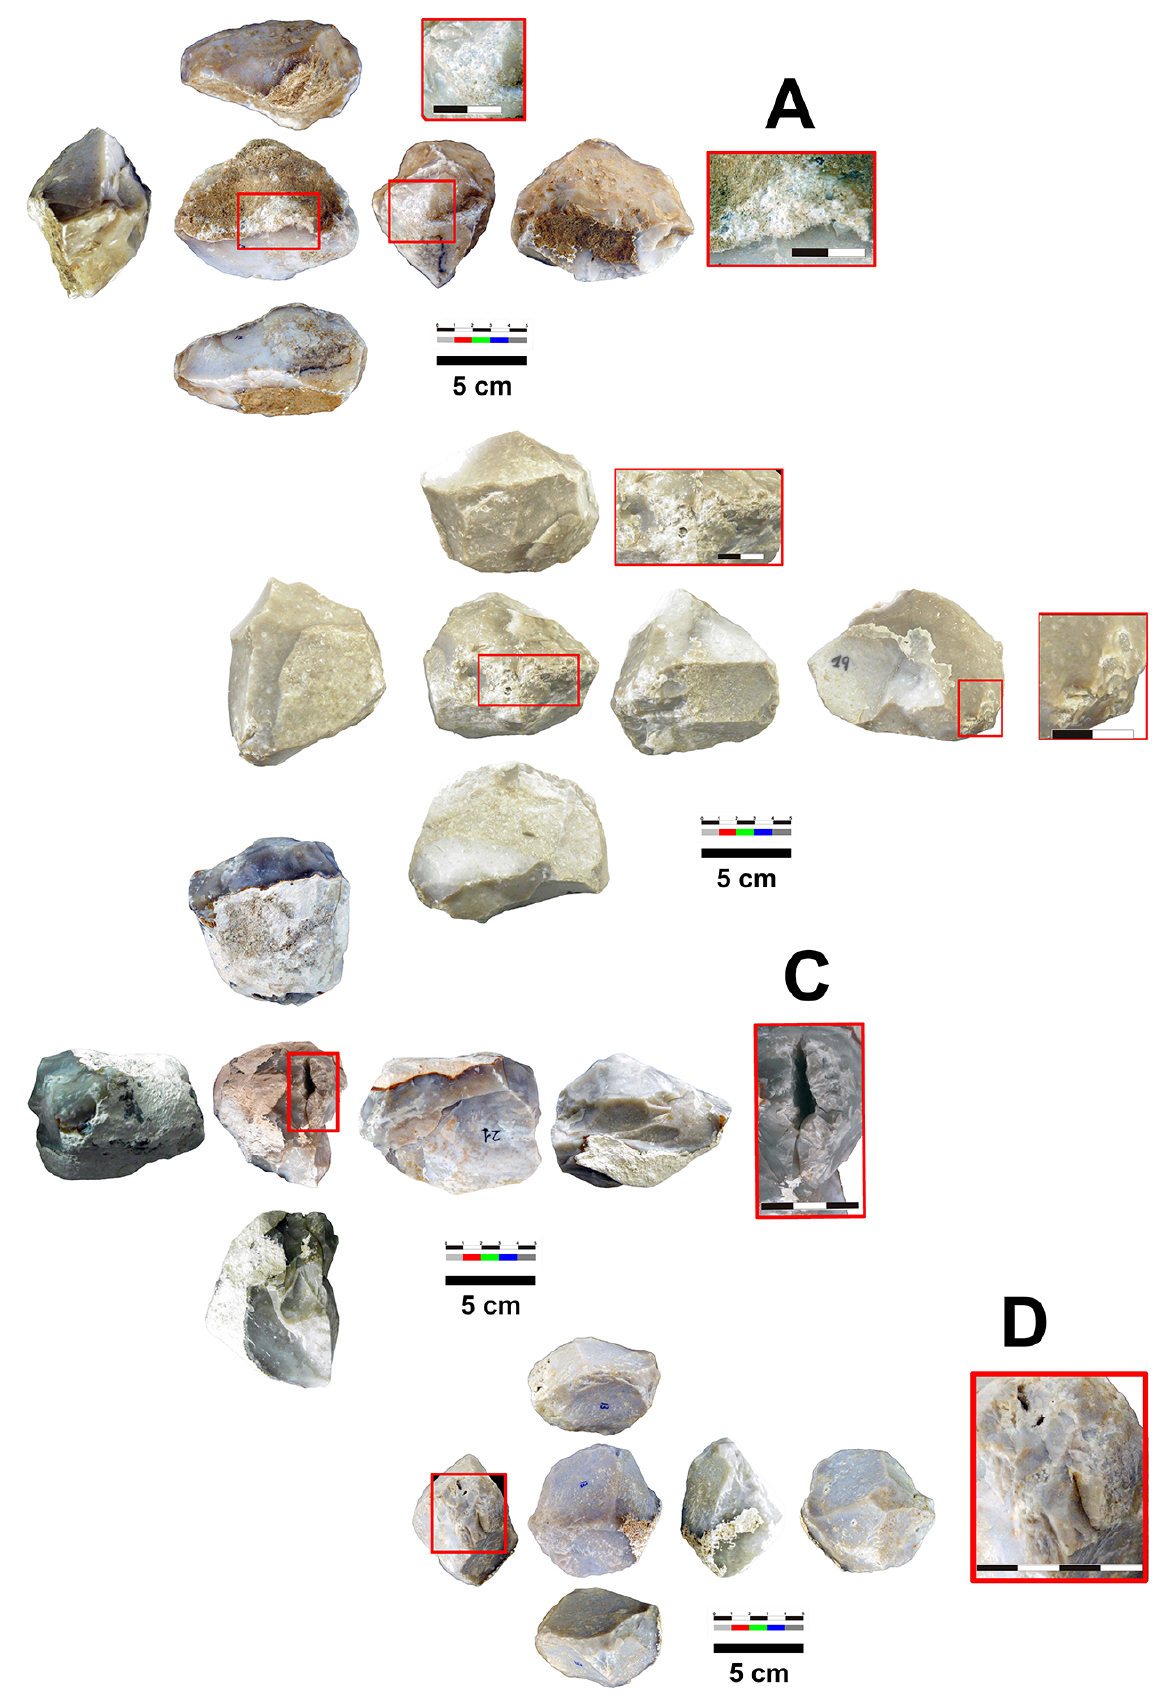
Figure 3. Selection of flint hammerstones used in different